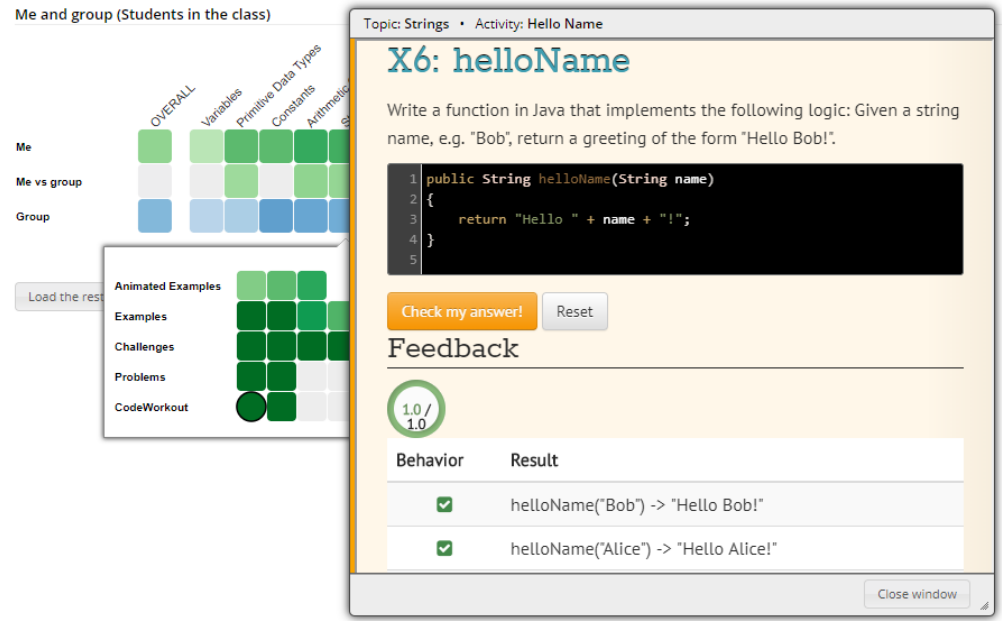
Figure 12. An instance of a CodeWorkout exercise accessed from the Mastery Grids